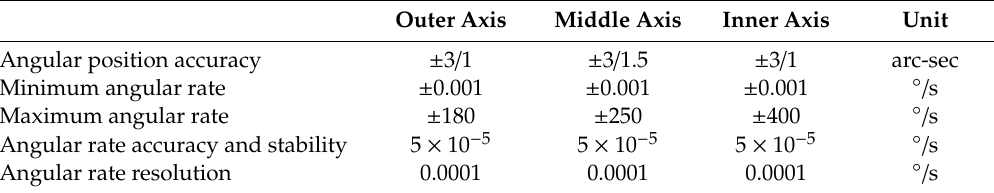
Figure 9. Description of the equipment of the turntable experiment. Table 3. Main parameters of the three-axis turntable.